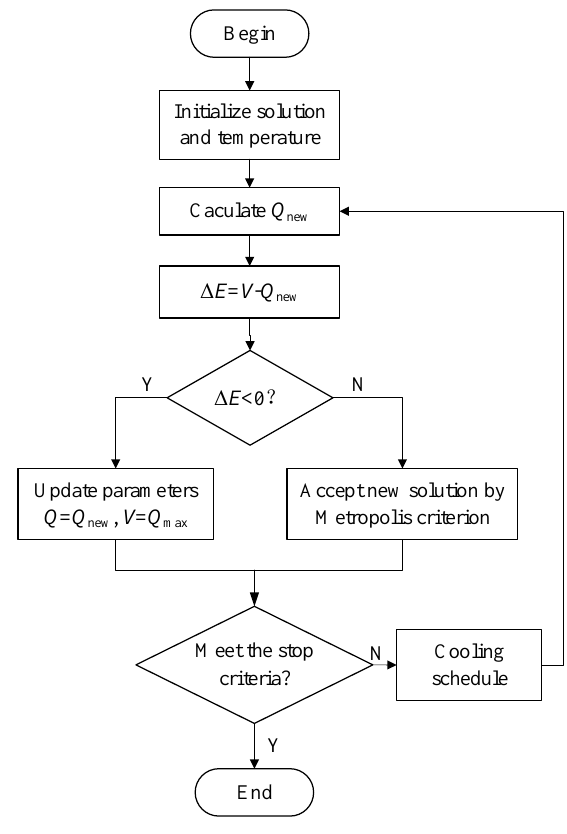
Figure 5. Flowchart of the SA-RL